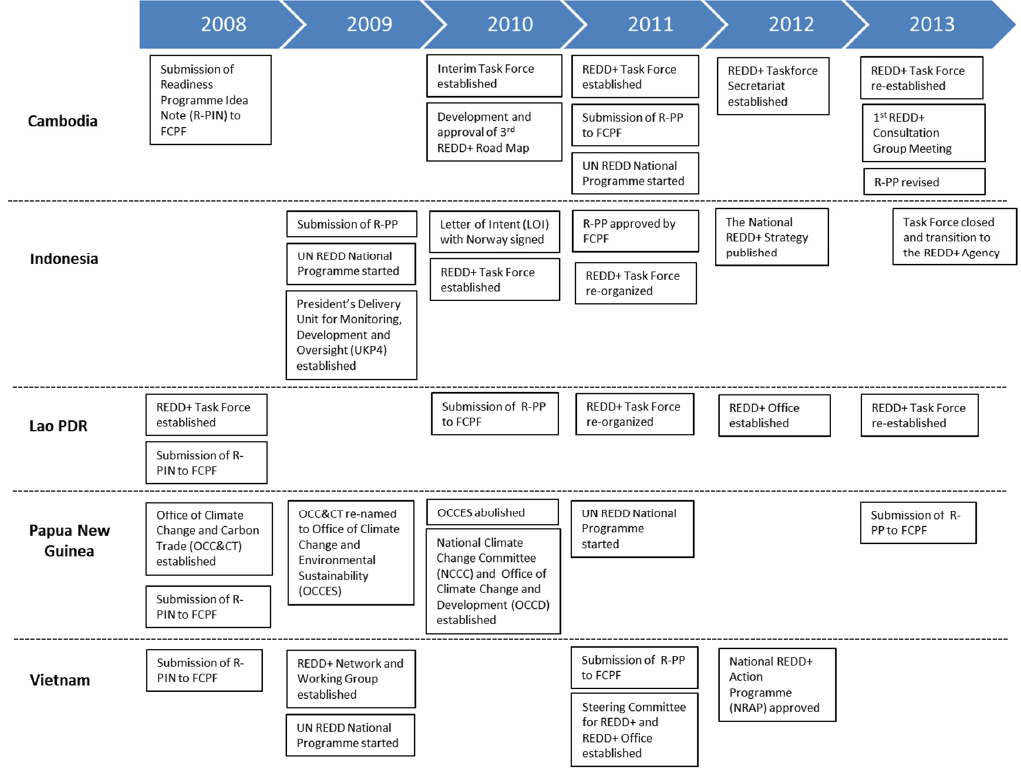
Figure 1. REDD+ timeline in the five countries 2008–2013 (Institutional frameworks and strategic Table 1. Institutional arrangements for REDD+ Readiness in the five countries in 2013